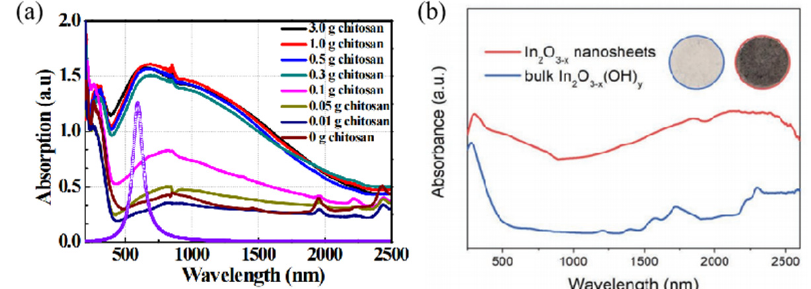
Figure 9. ( a ) Experimental absorption spectra of samples synthesized with different content of chitosan and simulated result by LSPR method (the dashed line) (Reprinted/adapted with permission from Ref. [68]. Copyright 2017, copyright Royal Society of Chemistry). ( b ) UV–vis–NIR spectra, inset: photograph ( left , bulk In 2 O 3-x (OH) y ; right , 2D black In 2 O 3-x ) (Reprinted/adapted with permission from Ref. [69]. Copyright 2020, copyright Wiley-VCH).